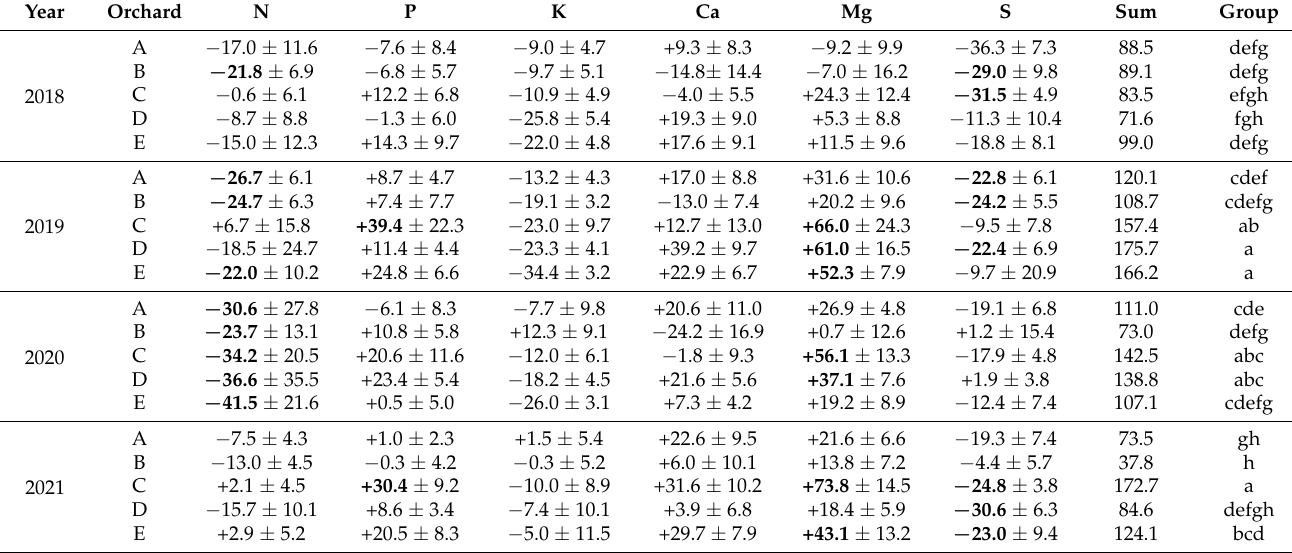
Table 6. DOP index (Deviation from Optimum Percentage) for leaves 90–110 DAFB. Reference values from DGADR (2011) [24]. Mean ± standard deviation of 9 individual DOP indices. Column Sum has the average of the 9 sums of the absolute values of DOP of each nutrient. Column Group indicates the sums that are significantly different, based on Tukey’s test at a 0.05 significance level. Bold values indicate that the element concentration is outside the range between the minimum and maximum